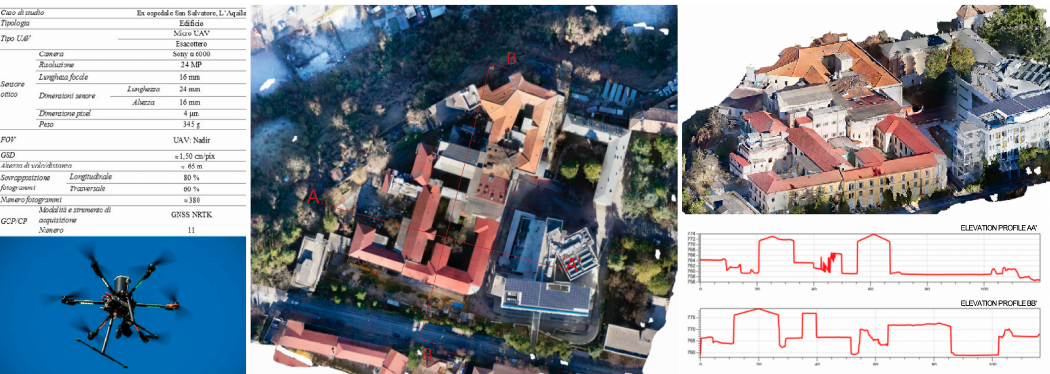
Figure 6. Unmanned aerial vehicle (UAV) photogrammetry. From left to right: features and views of the used vehicle; orthophotograph of roofing, three-dimensional reconstruction and elevation profiles obtained from the UAV campaign.